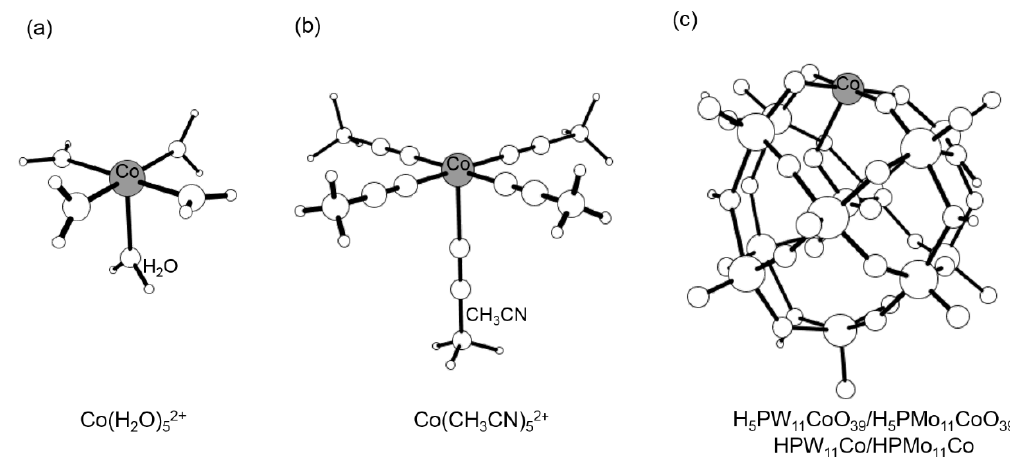
Figure 5. Structure of studied systems: Co-water complex ( a ), co-acetonitrile complex ( b ), and tungsten/molybdenum Keggin anion with cobalt introduced as one addenda atom ( c ).